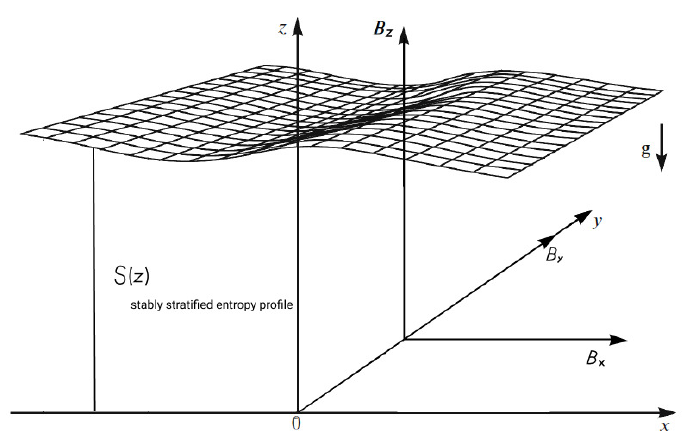
Figure 14. Geometry of a layer of plasma with stably stratified entropy (potential temperature)